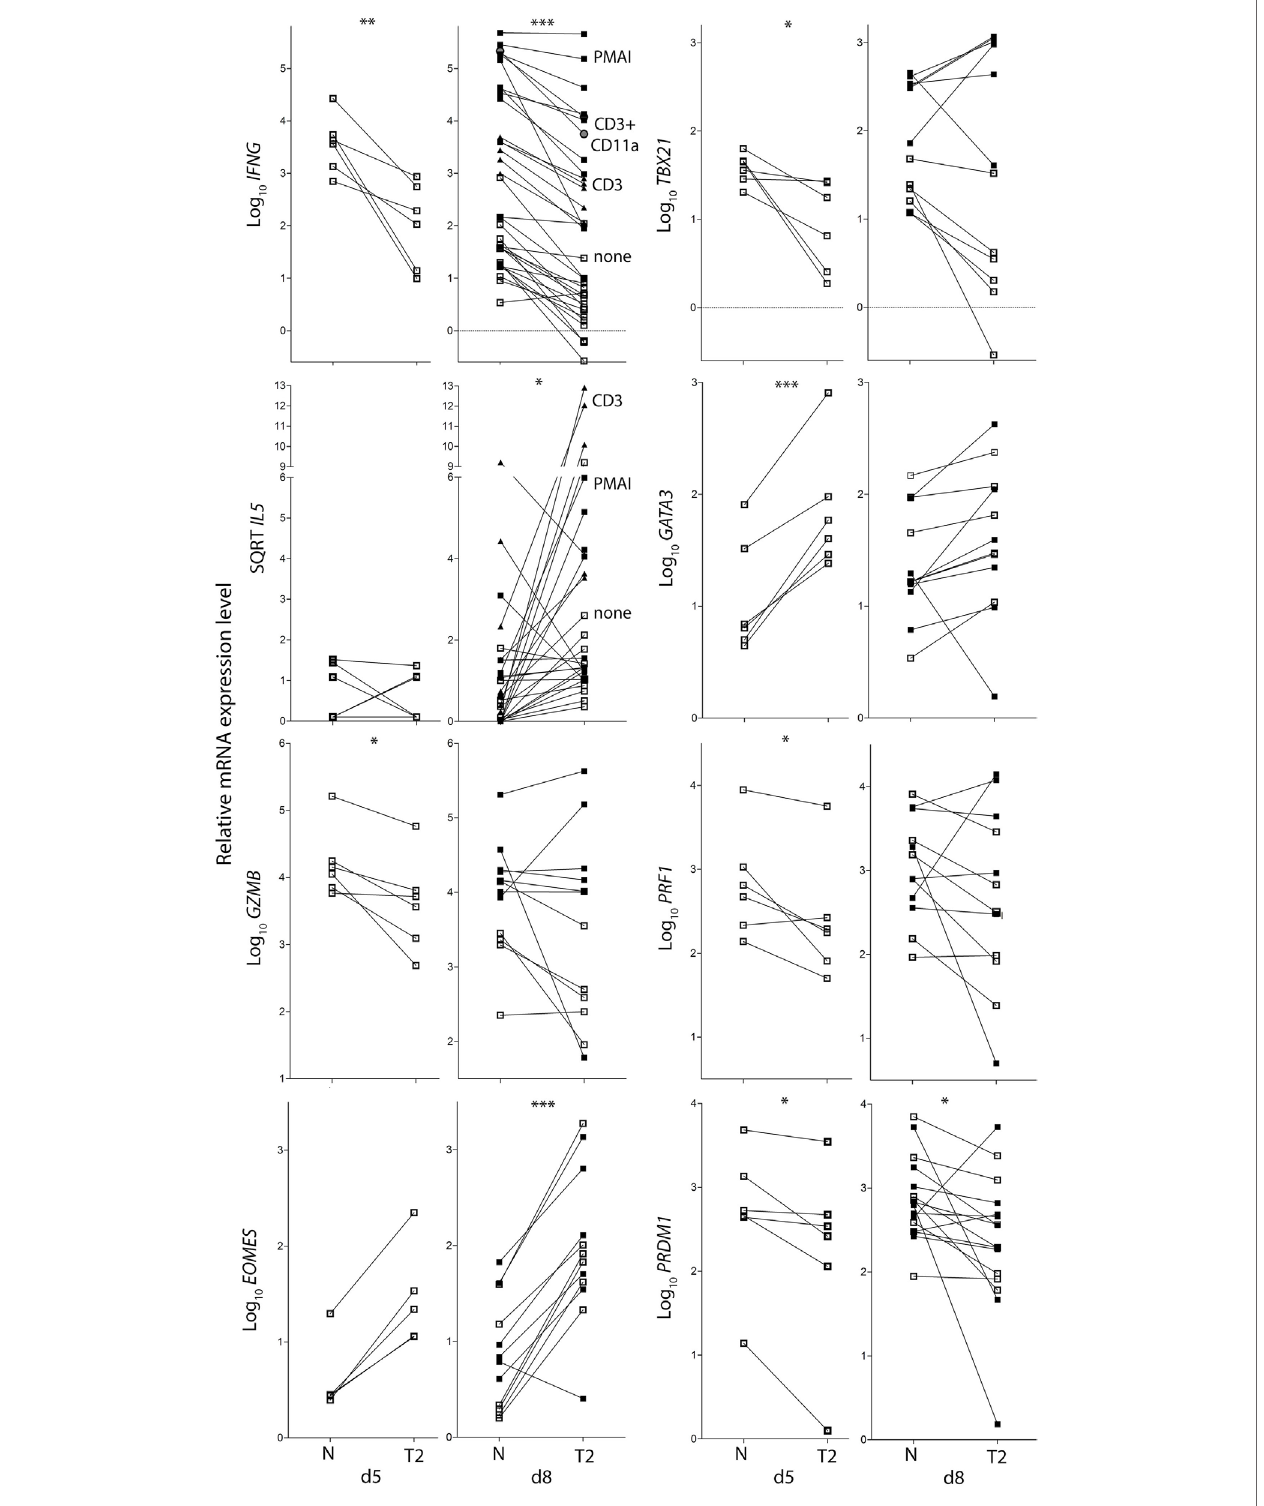
FigUre 3 | Cytokine and transcription factor mRNA expression in CD8 + T N activated in neutral or type-2 (T2) conditions. RNA was extracted from CD8 + T N directly after in vitro activation in N or T2 conditions for 5 days, or after an additional 3 days of rest with (see below) or without ( □ ) restimulation. Lines join N and T2-cultured cells from the same donor, n = 6–12. Cells were restimulated with PMAI ( ▪ ), anti-CD3 mAb ( ▴ ), or anti-CD3 with anti-CD11a mAb ( ● ). p -Values for pairwise comparisons of log 10 levels in neutral versus T2 conditions are indicated (*** p < 0.001, ** p < 0.01, and * p <